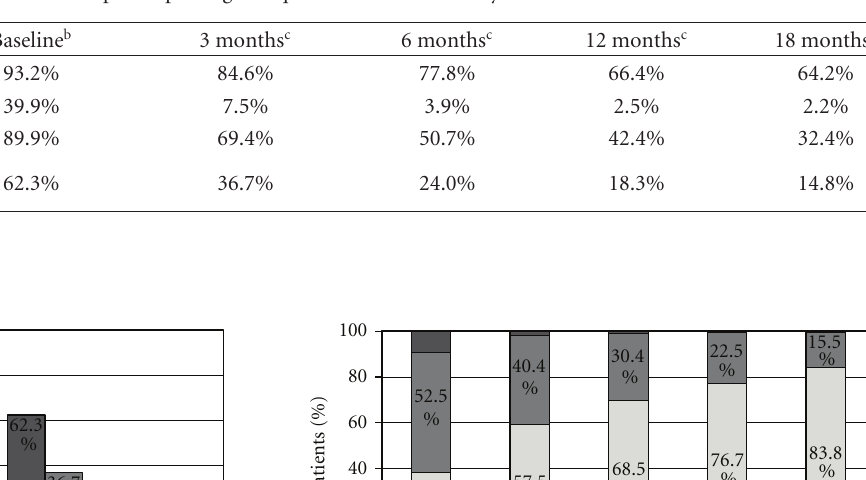
Table 2: Back pain reporting and qualification in the study course.